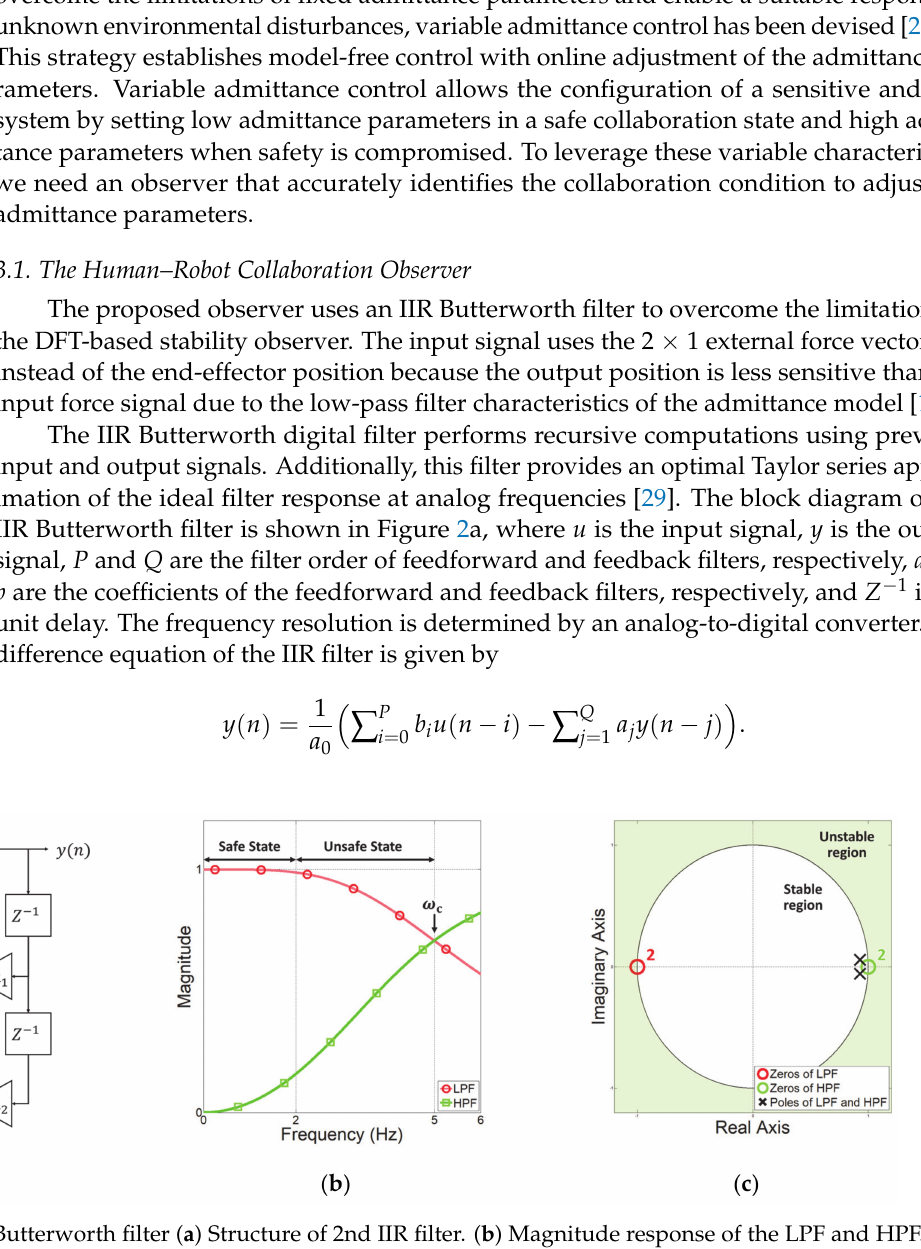
Figure 2. Design of the IIR Butterworth filter ( a ) Structure of 2nd IIR filter. ( b ) Magnitude response of the LPF and HPF. ( c ) Pole-zero map of LPF and